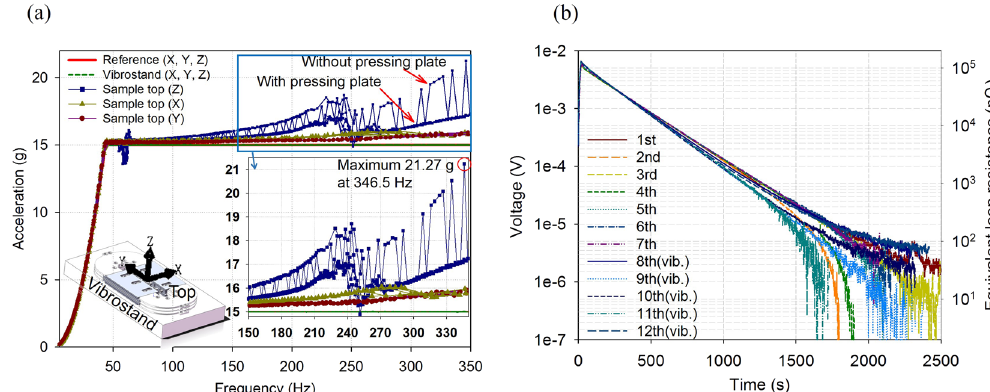
Figure 8. Mechanical and electrical properties in the vibration test. ( a ) The acceleration in Z-direction increases when frequency is > 250 Hz. A pressing plate (i.e., the cooling plate in the proposed system) is recommended to suppress the acceleration increasement. ( b ) Loop resistance stabilizes at < 75 nΩ no matter whether it is vibrated or not, and corresponding persistent-current lasting time is > 9.08